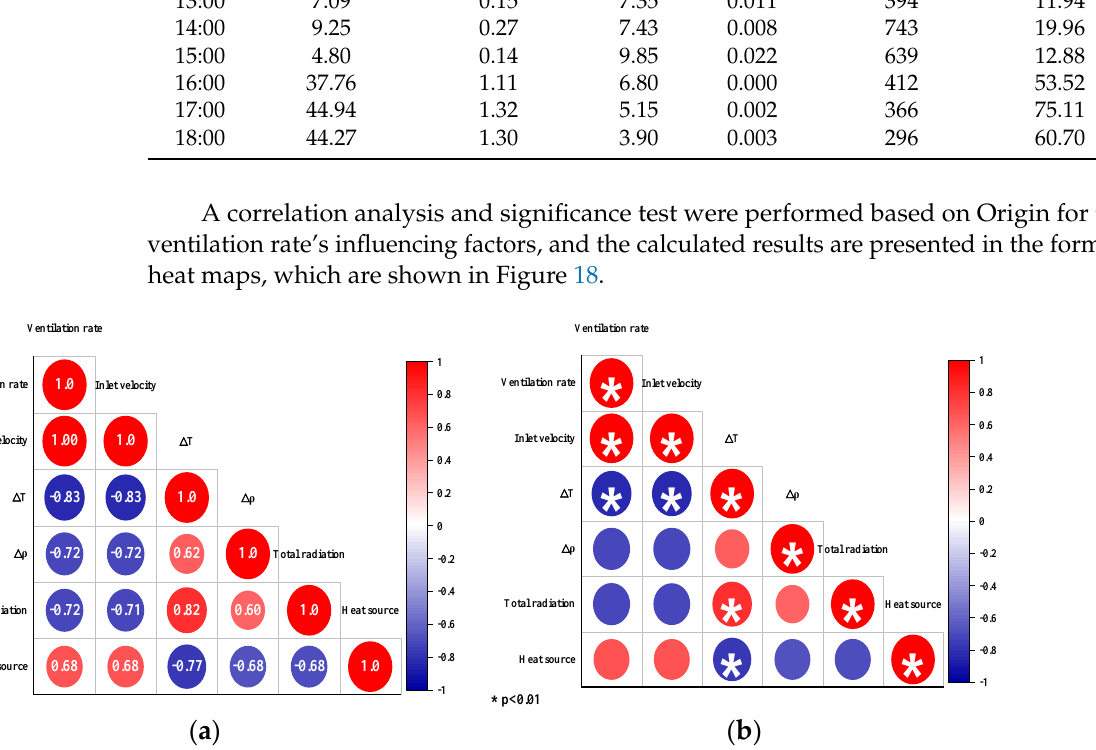
Figure 18. Ventilation rate correlation factor analysis. ( a ) Correlation coefficient calculation. ( b ) Significance analysis.